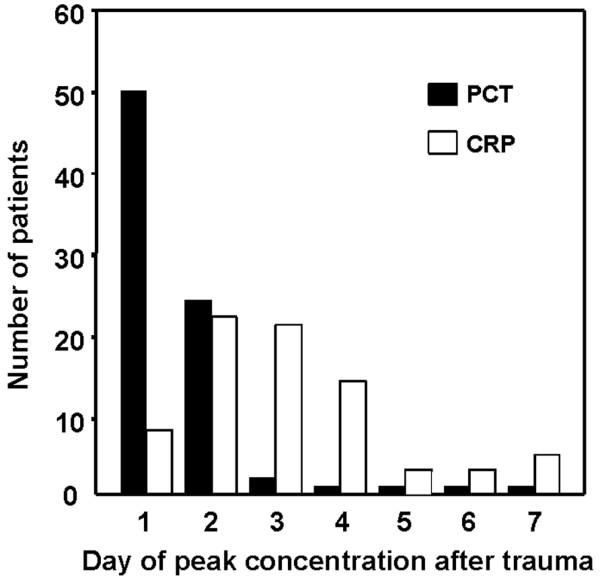
Histogram of the day of maximum concentrations of procalcitonin (PCT) and C-reactive protein (CRP) in multiple-trauma patients.